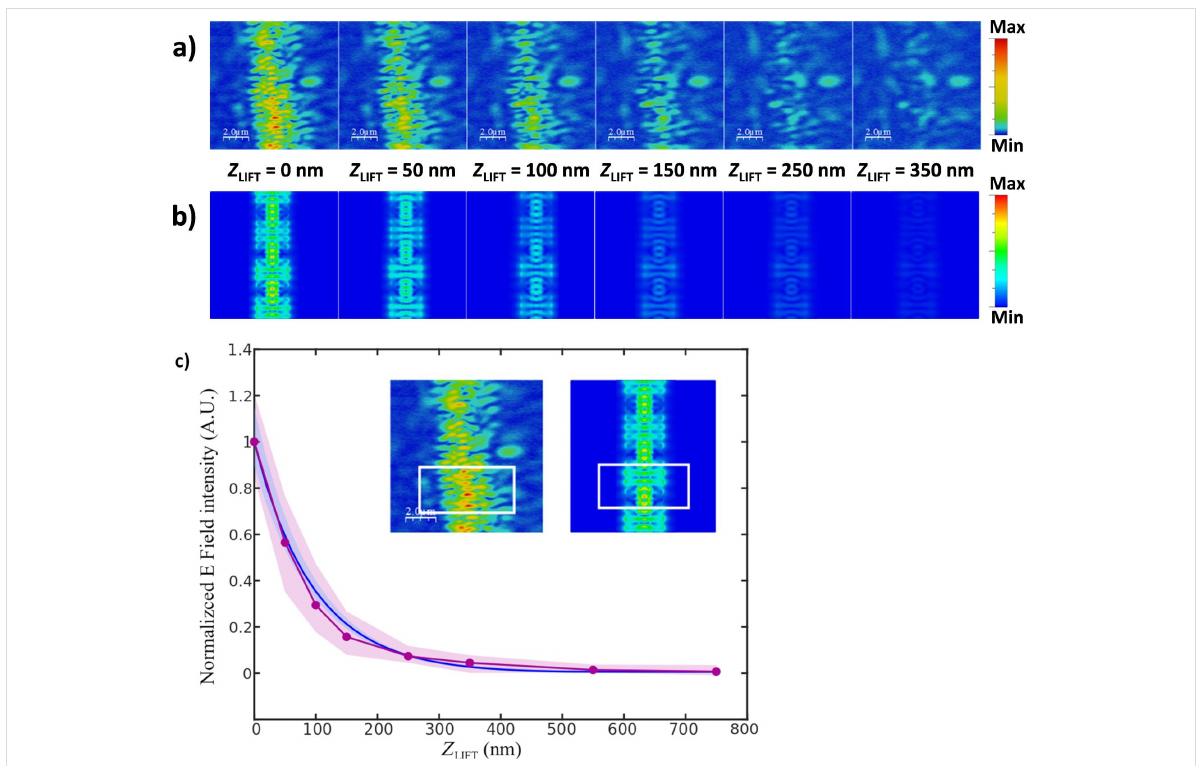
Figure 4: (a) SNOM-measured and (b) FDTD-simulated near field at different vertical distances ( Z LIFT ) from the surface of the PBG sensing structure. An excitation wavelength of 1570 nm is used for the SNOM measurements, while a wavelength of 1550 nm has been used in the FDTD simulations in order to consider the same scenario. (c) Normalized intensity of the evanescent field as a function of the distance from the sensor surface for the SNOM measurements (purple) and for the FDTD simulations (blue). The shaded areas represent the standard deviation of the raw SNOM measure- ments and the FDTD simulations along the area of the PBG structure highlighted in the insets.